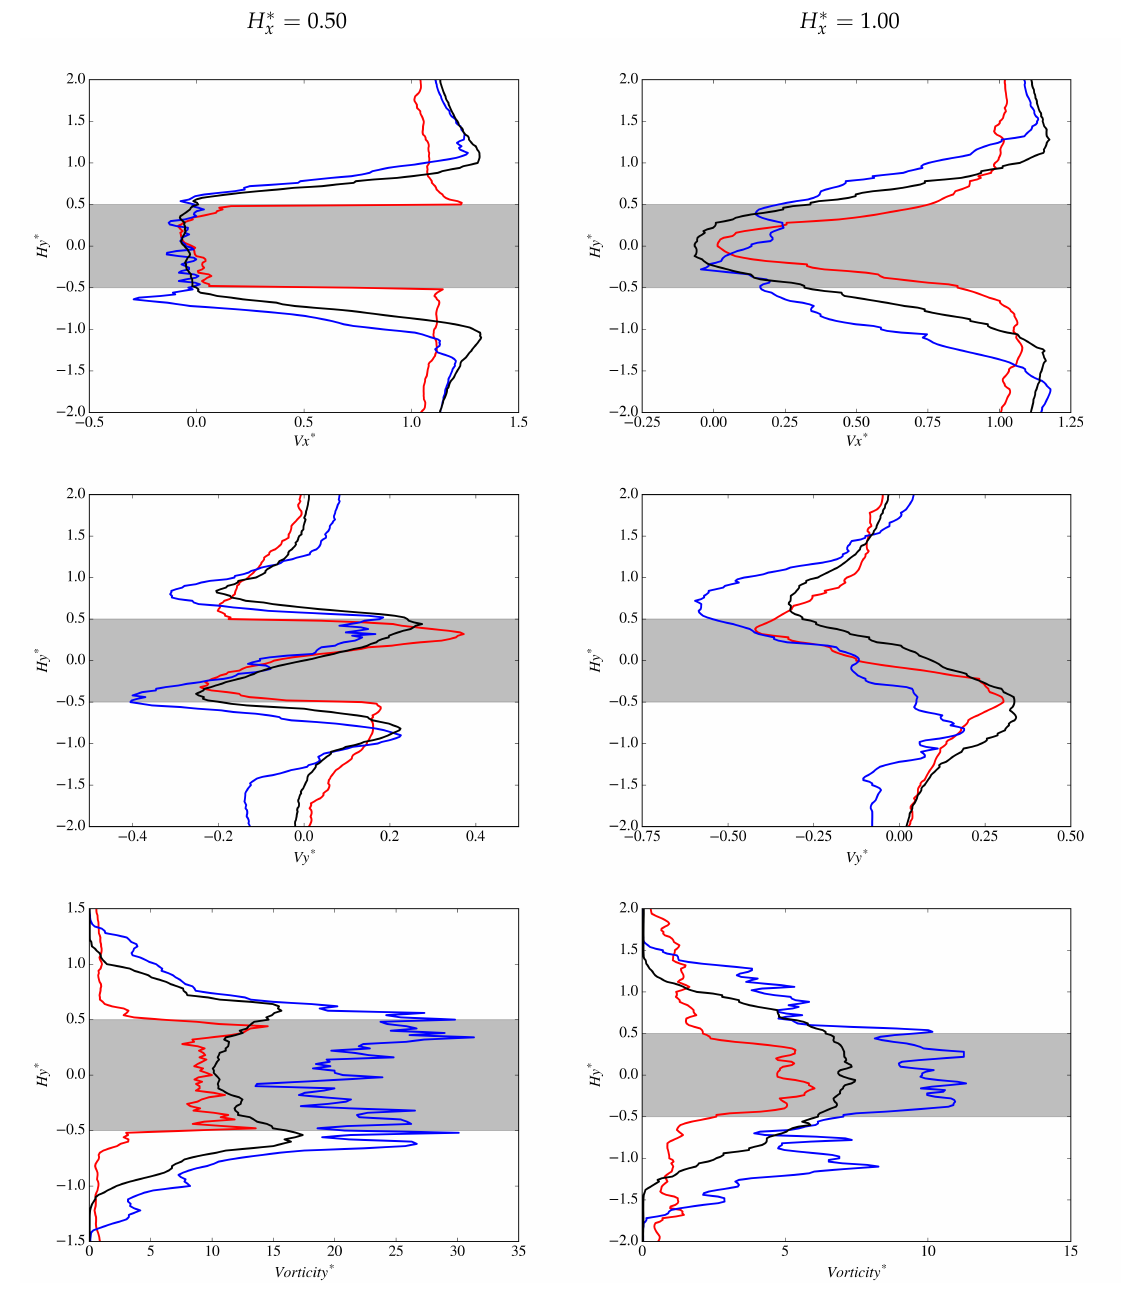
Figure 15. Wake variations of: ( Top ) non-dimensional streamwise velocity, V ∗ x ; ( Middle ) non-dimensional cross-stream velocity V ∗ y ; and ( Bottom ) non-dimensional vorticity magnitude | ω | ∗ at probe location H ∗ x = 0.50. The red, blue and black lines represent 0 < a x , a x < 0 and a x = 0 cases,